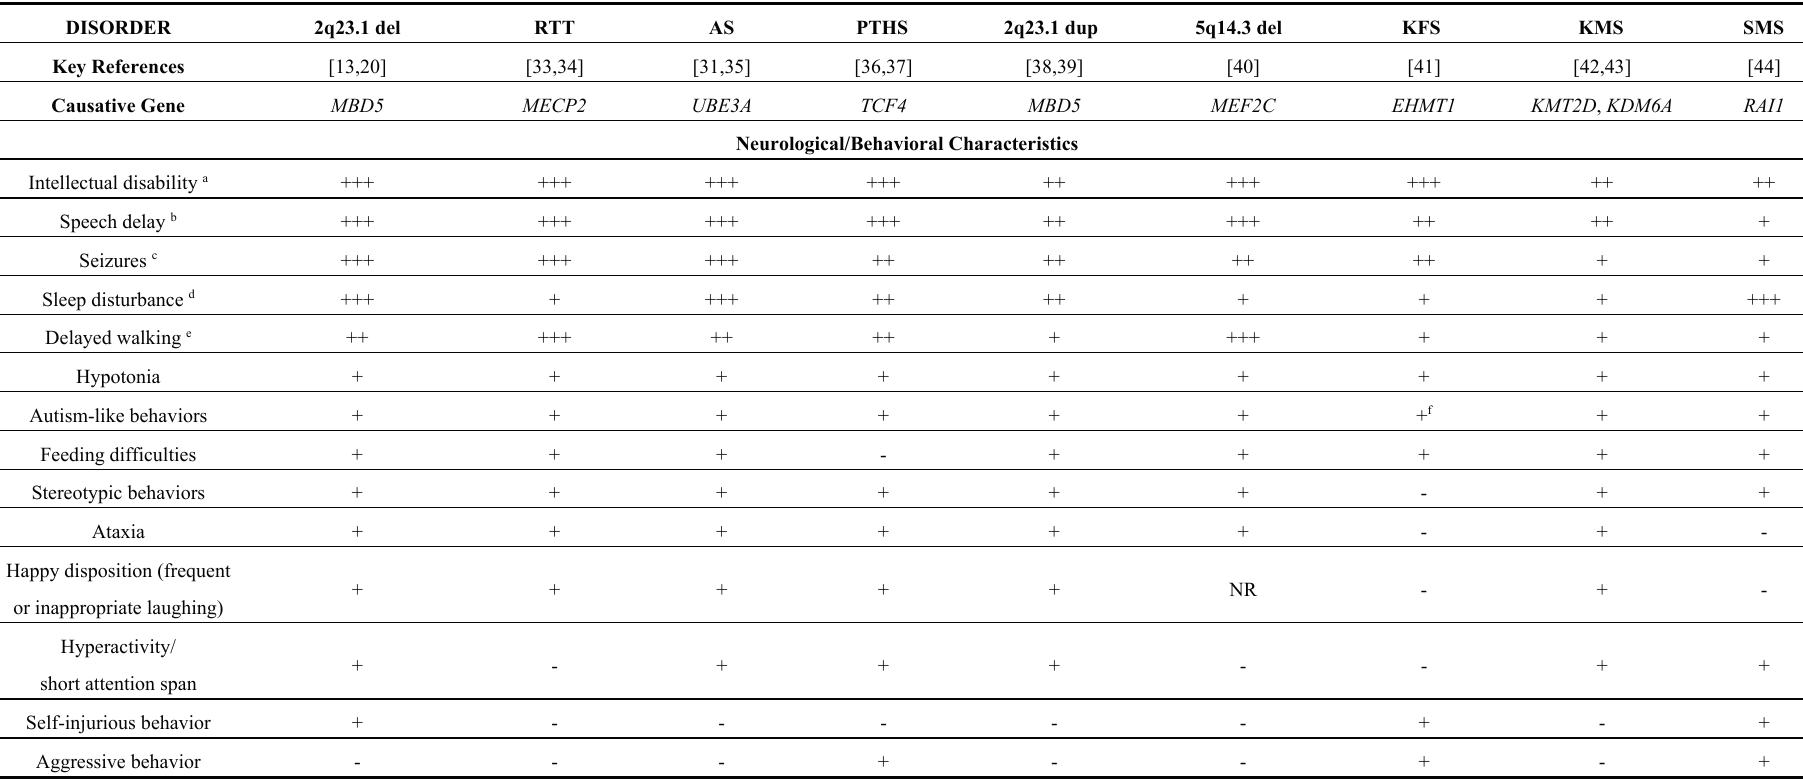
Table 2. Common phenotypes between 2q23.1 deletion syndrome and Rett, Angelman, Pitt-Hopkins, 2q23.1 duplication, 5q14.3 deletion, Kleefstra, Kabuki, and Smith-Magenis